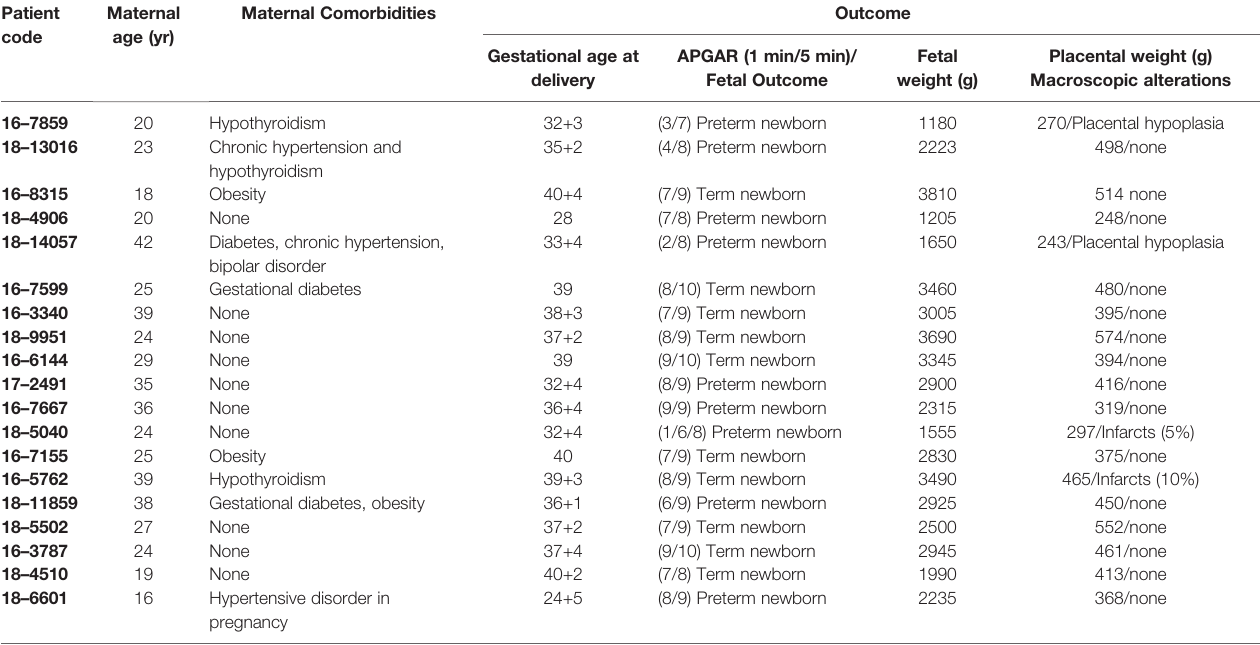
TABLE 2 | Clinical information of the Control group. Patient